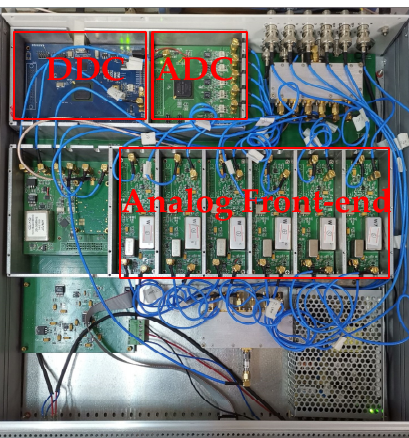
Figure 3. The signal processing part of the indoor equipment.